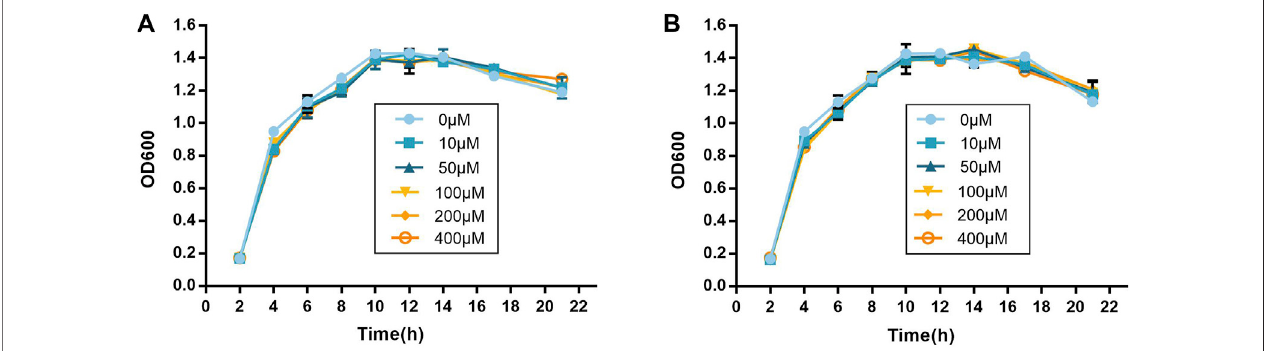
FIGURE 3 | Inhibitory effect of compound no.3 and compound no.10 on (A) pyocyanin and (B) elastase productions of P. aeruginosa PAO1.